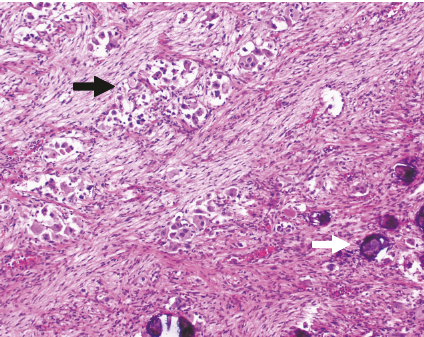
weight 48.5 kg (BMI 20.7 Kg/m 2 ), blood pressure was 110/ 70 mmHg, pulse rate 64 beats/min, and SpO 2 99% (room air).